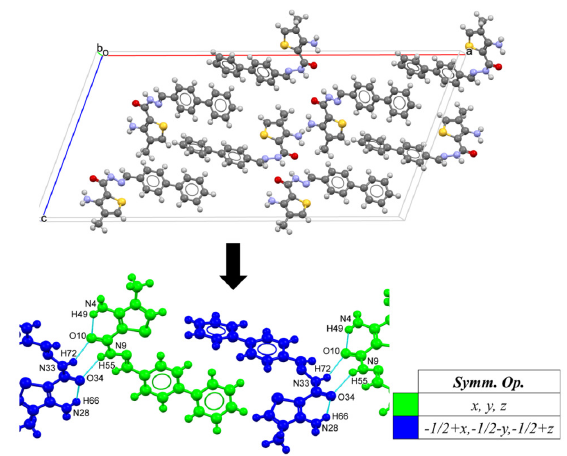
Figure 4 - (Top) Unit cell representation of compound 8j recognized by X-ray powder diffraction. (Bottom) The hydrogen inter/intramolecular interactions between the atoms from different equivalent symmetry operations are displayed in cyan